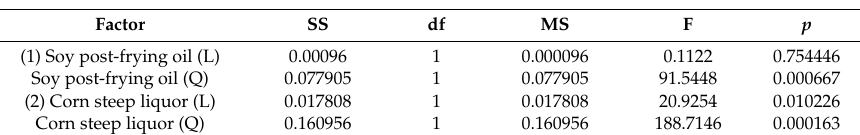
Table 3. ANOVA results for the quadratic model of AE in canola oil. ANOVA; Var.: Canola oil (AE); R-sqr = 0.98329; Adj: 0.96936 (2**(2) central composite, nc = 4 ns = 4 n0 = 2 factors, 1 Blocks, 12 Runs; MS Pure Error =